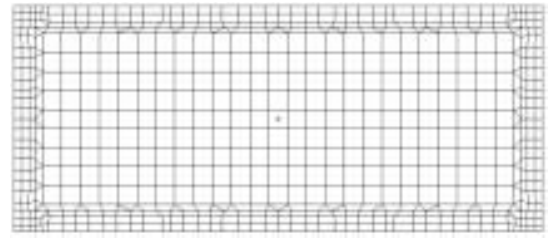
Fig. 3. Finite element model of the box floor for damping material optimization.